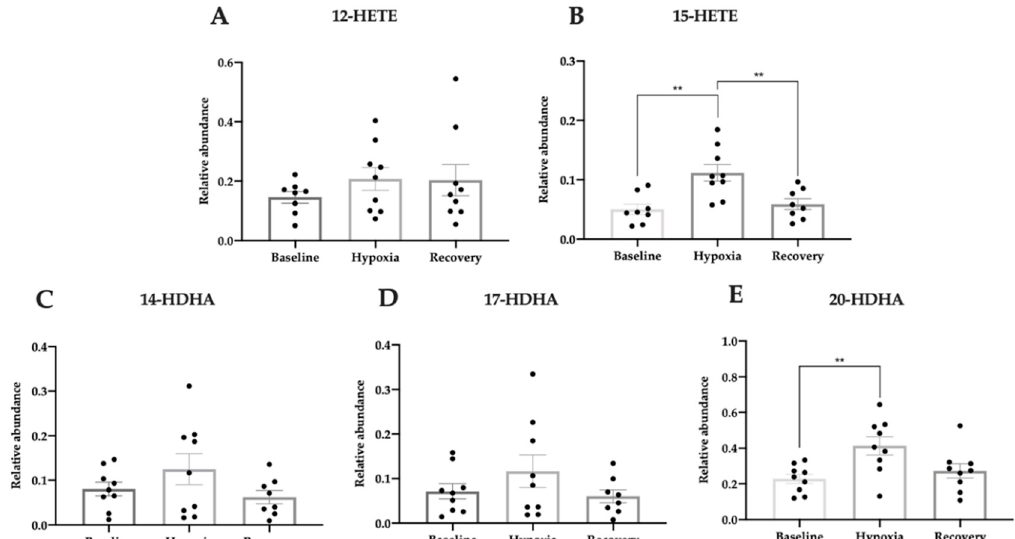
Figure 8. Relative abundance of pro-homeostatic lipid mediators during hypoxic exposure in controls measured in plasma by LC-MS / MS. The metabolites of arachidonic acid, 12-HETE ( A ) and 15-HETE ( B ), and oxygenation products of DHA, 14-HDHA ( C ), 17-HDHA ( D ), and 20-HDHA ( E ) were measured. Dataarepresentedasmean ± SEM.One-wayANOVAwithTukey’smultiplecomparisonstest.** p <